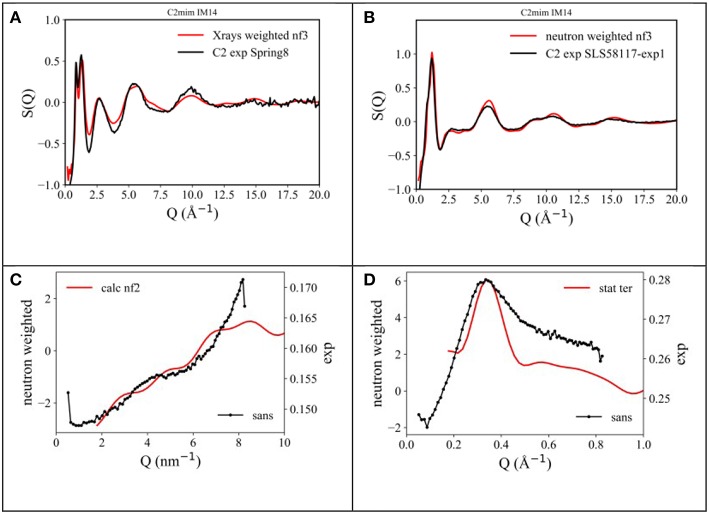
Comparison between (A) X-ray and (B) neutron diffraction data and the output from present MD simulations for the case of [C2mim][IM14] at ambient conditions. Also, comparison between experimental (black line) and un-normalized MD-computed (red line) SANS data from [Cnmim][IM14], with (C)
n = 4 and (D)
n = 8, respectively, at ambient conditions.